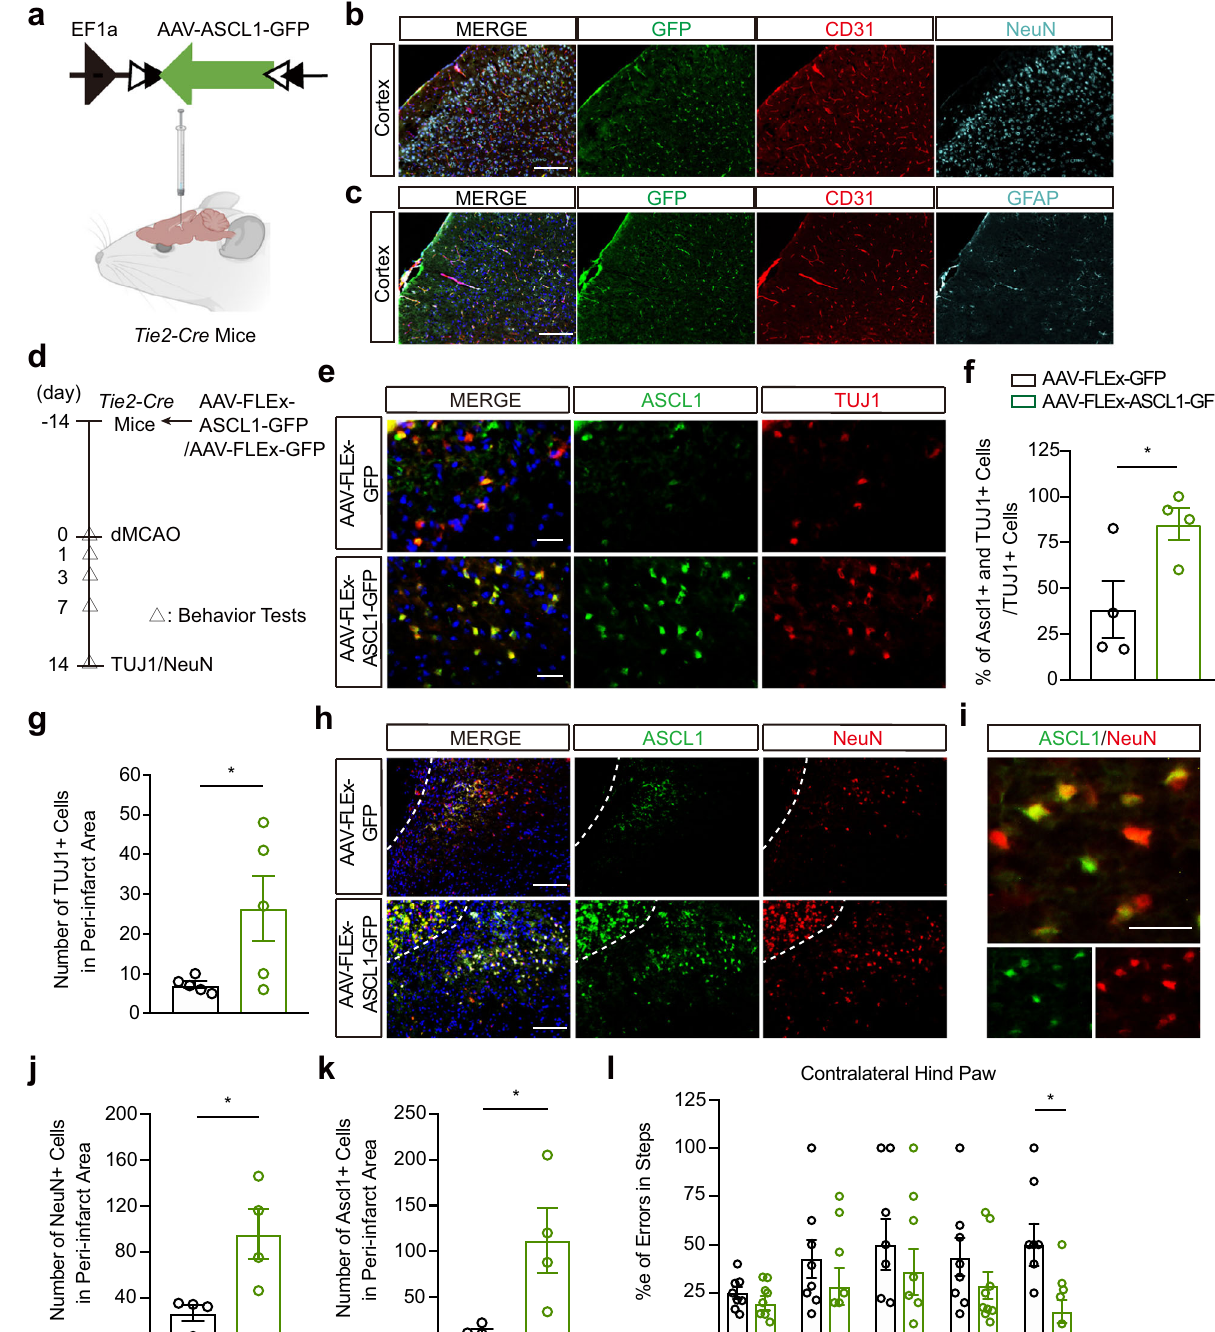
Fig. 6 | Overexpression of Ascl1 in brain endothelial cells increases neurogen- esis and improves neurological recovery after focal cerebral ischemia. a AAV- FLEx-ASCL1-GFP or AAV-FLEx-GFP was injected into lateral ventricle of the Tie2-cre mice.CreatedwithBioRender.com. b RepresentativeimmunostainingofGFP,CD31 and NeuN in cortex at day 8 post AAV-FLEx-ASCL1-GFP injection. c Representative immunostaining of GFP, CD31 and GFAP in cortex at day 8 post AAV-FLEx-ASCL1- GFP injection. d Experimental design. e Representative immunostaining of Ascl1 and TUJ1 at day 14 post permanent distal MCAO. f Quanti fi cation of TUJ+ cells expressing Ascl1 in the peri-infarct area (totally 3 sections per mouse, 4 mice per group); p =0.0392. g Quanti fi cation of TUJ1+ cells in the peri-infarct area (totally 3 sections per mouse, 5 mice per group); p =0.0496. h Representative